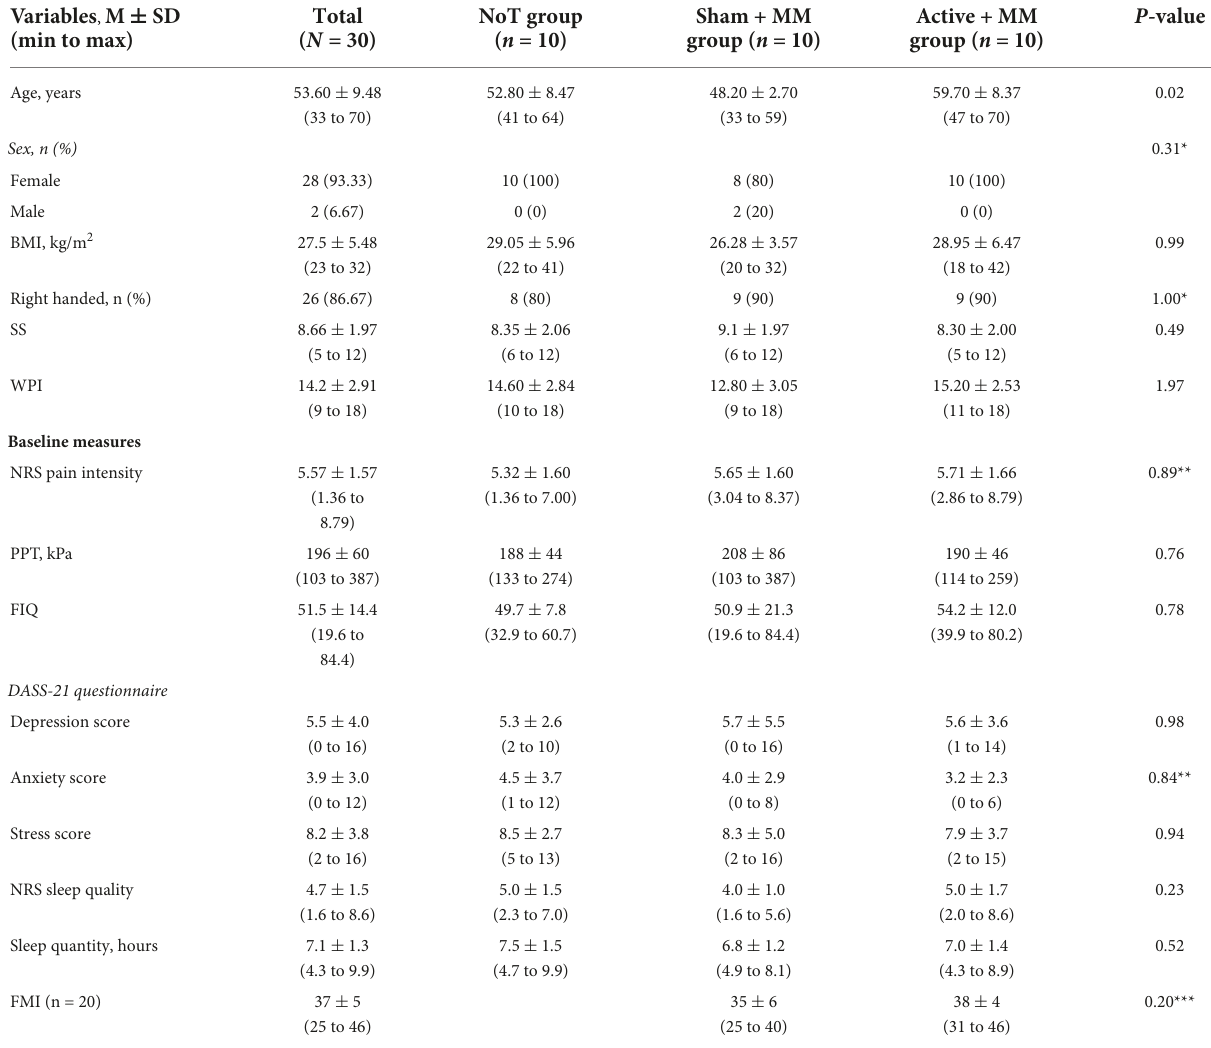
TABLE 1 Baseline demographic and clinical characteristics among